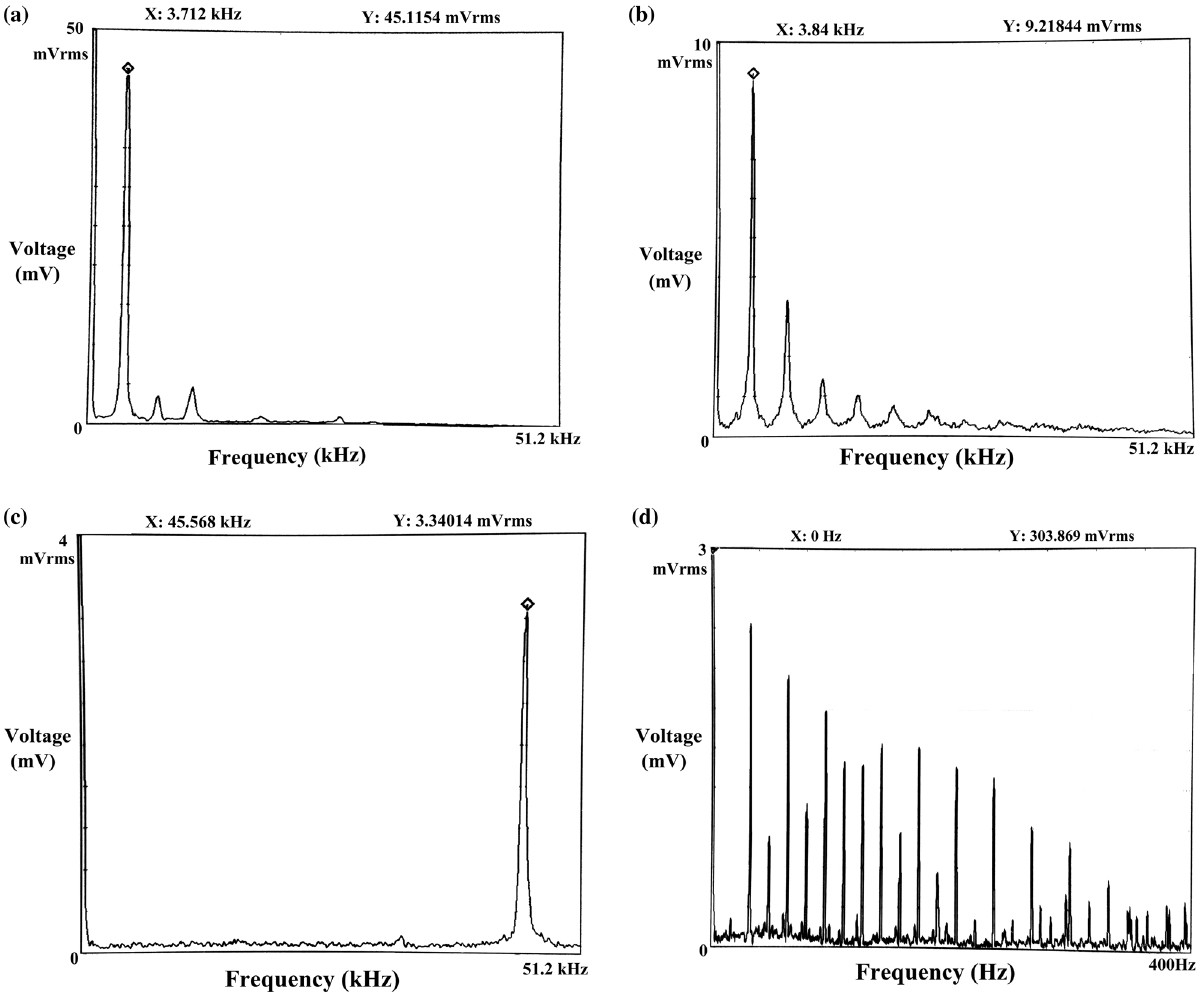
FIG. 4. (a) Generation of maximum amplitude of plasma instability, (b) harmonics generation for plasma instabilities, (c) tunable and unique plasma instability frequency, and (d) low frequency oscillations in ECR ion sources.